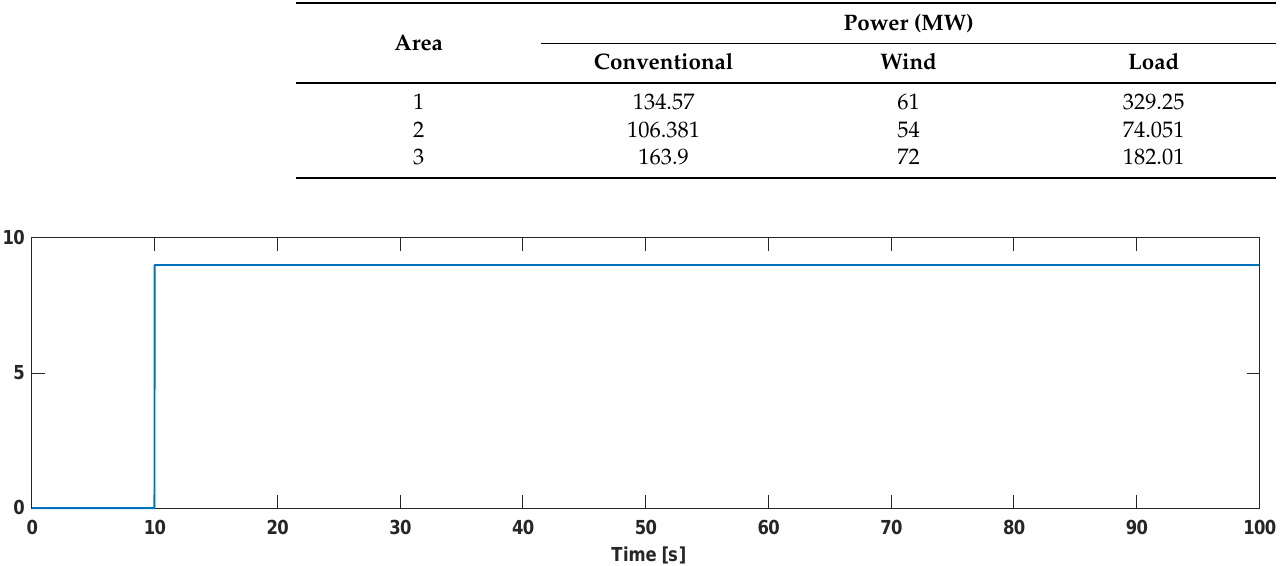
Figure 11. Example 2: The trajectory of load